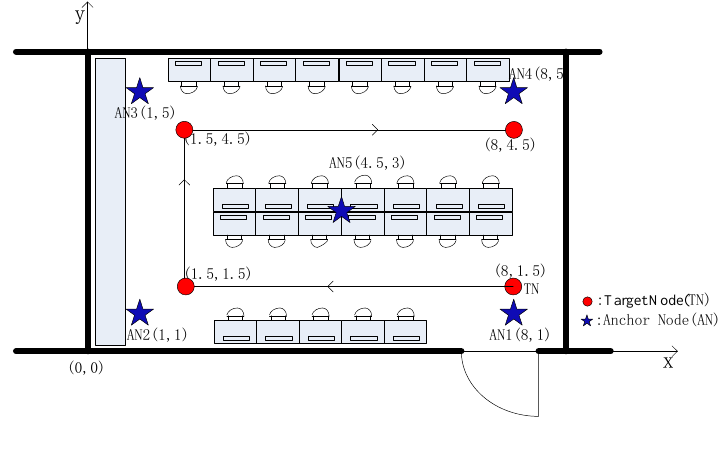
Figure 1. Environment deployment.